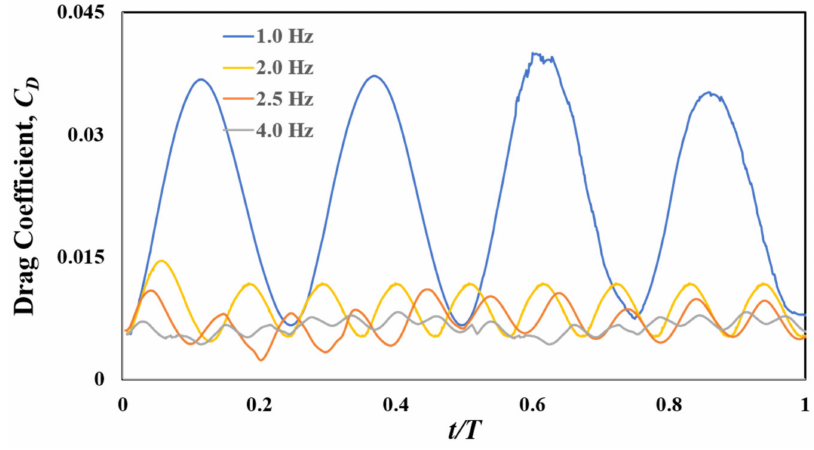
Figure 10. Instantaneous drag coefficient for station TLC entrained to the side of the obstruction.